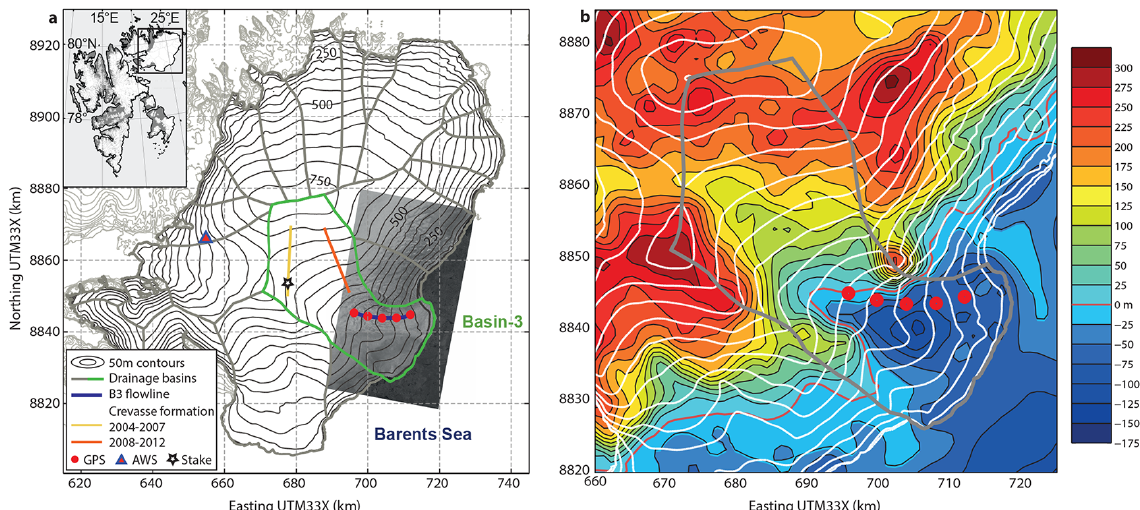
Figure 1. Surface and bedrock topography of Austfonna/Basin-3. (a) Surface elevation contours at 50m interval (solid black), overlain on a TerraSAR-X backscatter image (30 April 2012). The insert provides the ice cap’s location within the Svalbard archipelago. Drainage basins are outlined in solid grey; Basin-3 is outlined in solid green. The positions of five GPS receivers and one stake on Basin-3, as well as the automatic weather station (AWS), are marked. Repeat-GPR profiling revealed crevasse formation in upper reaches of Basin-3 between 2004 and 2007 and between 2008 and 2012 (Appendix D). (b) Bedrock contours (black, colour-filled) are at 25m intervals, with the bedrock sea-level contour highlighted in red and 50m surface elevation contours superimposed